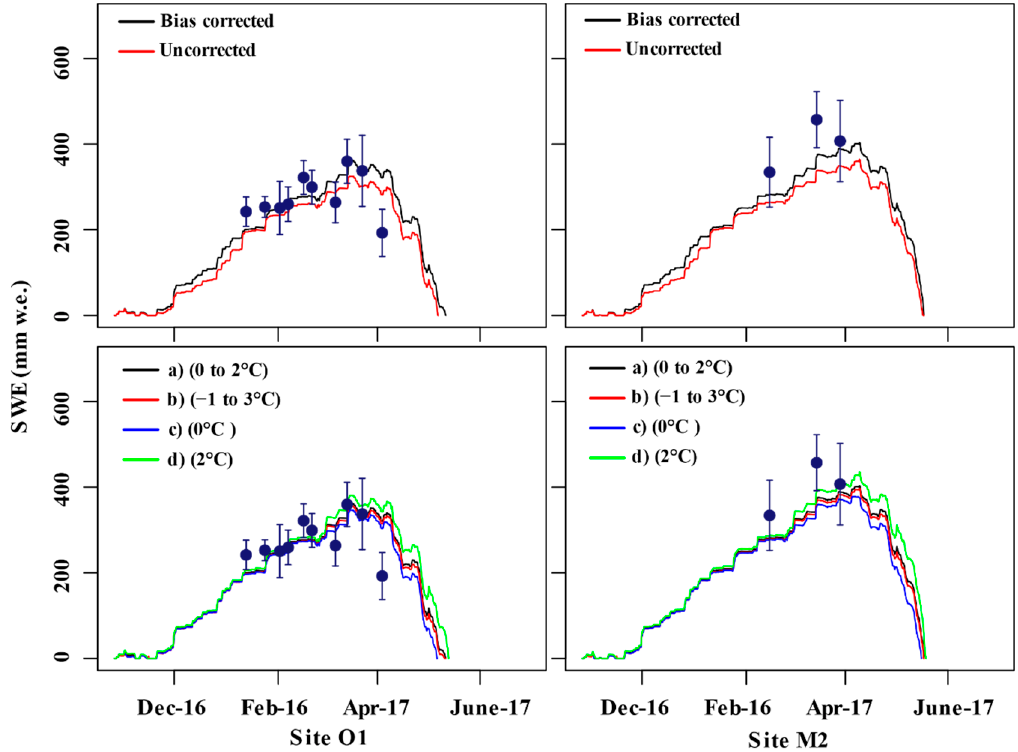
Figure 10. Effects of precipitation uncertainty (amount and phase) on modelled SWE at hourly time steps using the best-performing TI model from Phase II (with sublimation), at sites O1 (left) and M2 (right). Top panel: Modelled SWE using bias corrected vs. uncorrected precipitation data. Bottom panel : Impacts of various phase partitioning approaches. Four approaches are tested: a) the linear partitioning of rain and snow between air temperatures of 0 to 2 °C; b) the linear partitioning of rain and snow between air temperatures of − 1 to 3 °C; c) snow and rain below and above 0 °C; d) snow and rain below and above 2 °C. Blue dots stand for the mean SWE, whereas the error bars denote the standard deviation. Table 3. Metrics for the best-performing TI model from Phase II (with sublimation) considering precipitation undercatch and precipitation phase comparison. BC = bias corrected, UC = uncorrected precipitation.